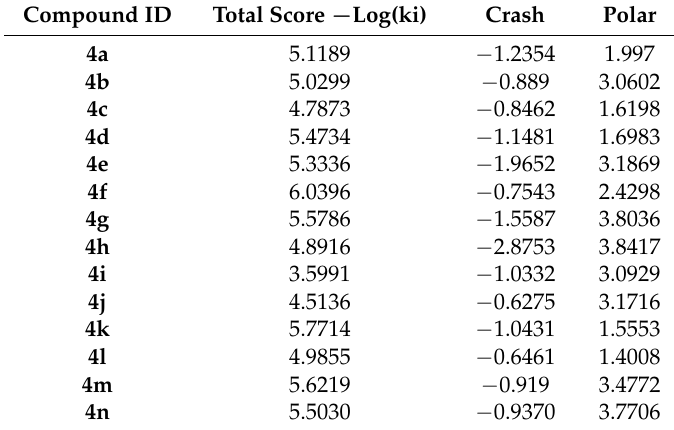
Table 3 . Molecular docking study data of the compounds 4 ( a – n ) in TRK.